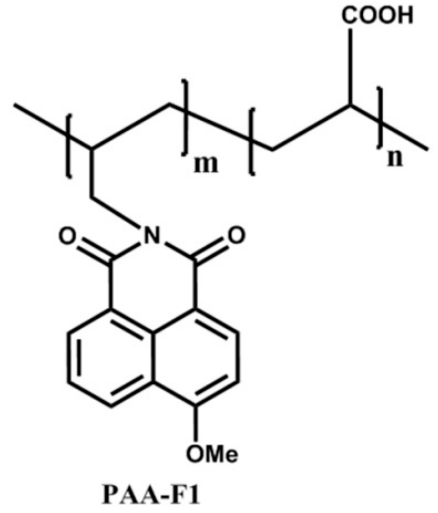
Figure 1. Molecular structure of naphthalimide-tagged polyacrylate PAA-F1.